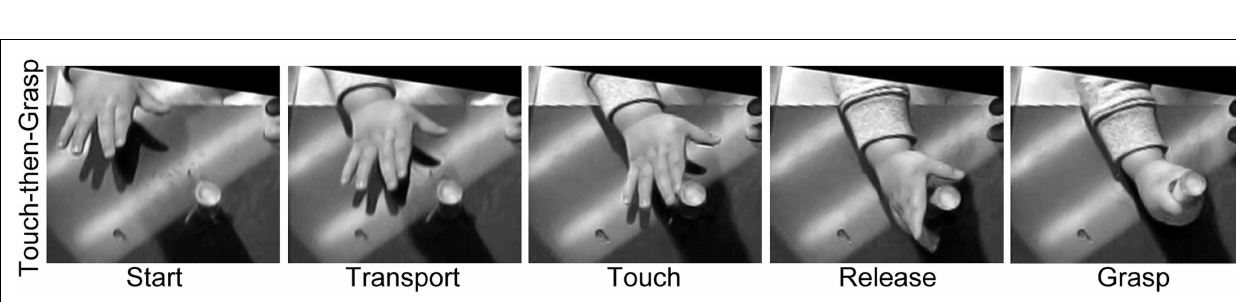
available the monkey advances an open hand toward the target, and only shapes and closes the hand to grasp the target after it has been touched [videos provided by Lawrence (54)].